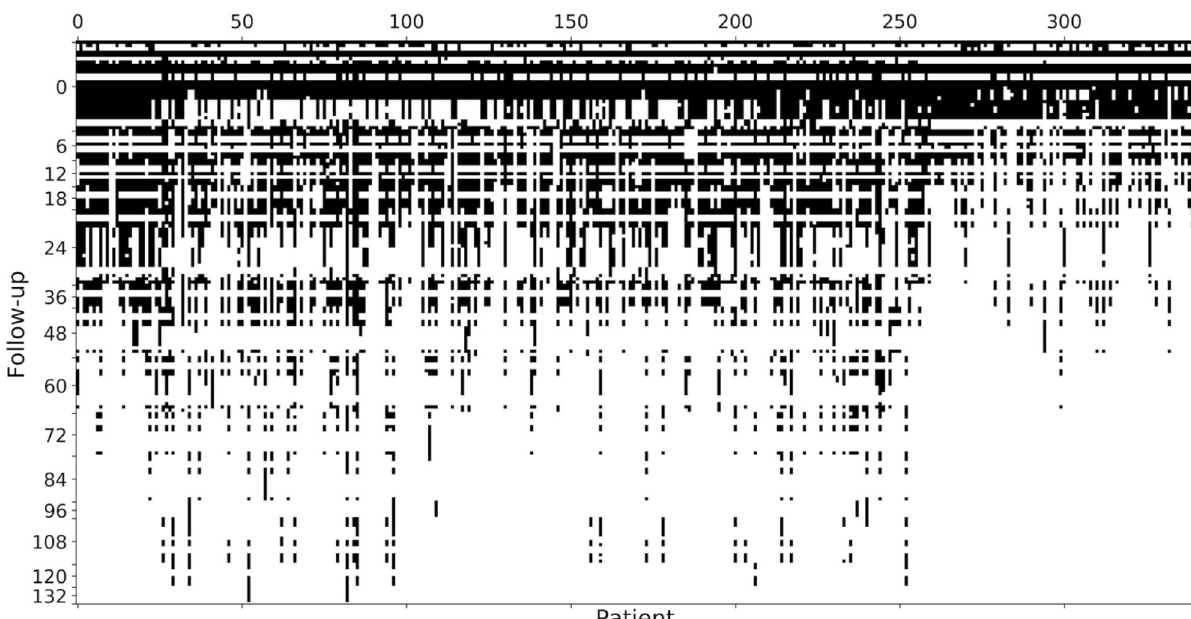
Figure 1. A spy plot about the presence of values on the whole dataset: black indicates available data, white missing. The numbers on the ticks on the vertical axis indicates the follow-up months, while the ticks without numbers indicate the gap between two separate follow-ups. The pattern is typical of longitudinal studies: such distribution highlights the problem when results are produced via the classical descriptive statistical approach, where the model is confirmed in terms of confidence intervals and probability distributions with a quite limited data set. ML with tree techniques can overcome this feature using all the available data.